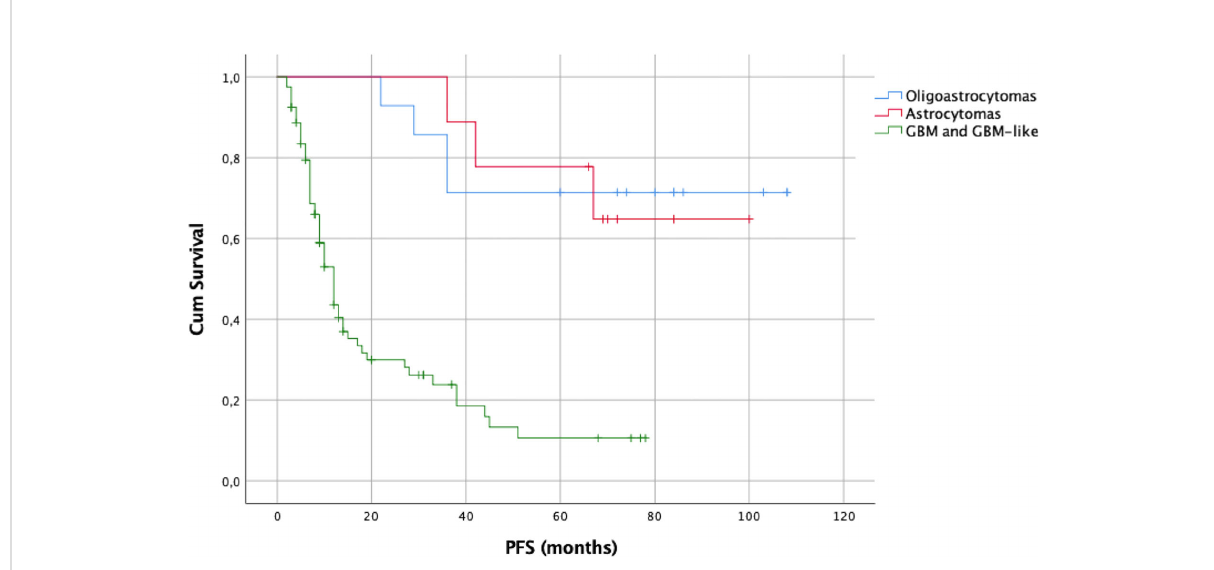
FIGURE 11 Kaplan – Meier curves of PFS according to glioma molecular subtypes at fi rst